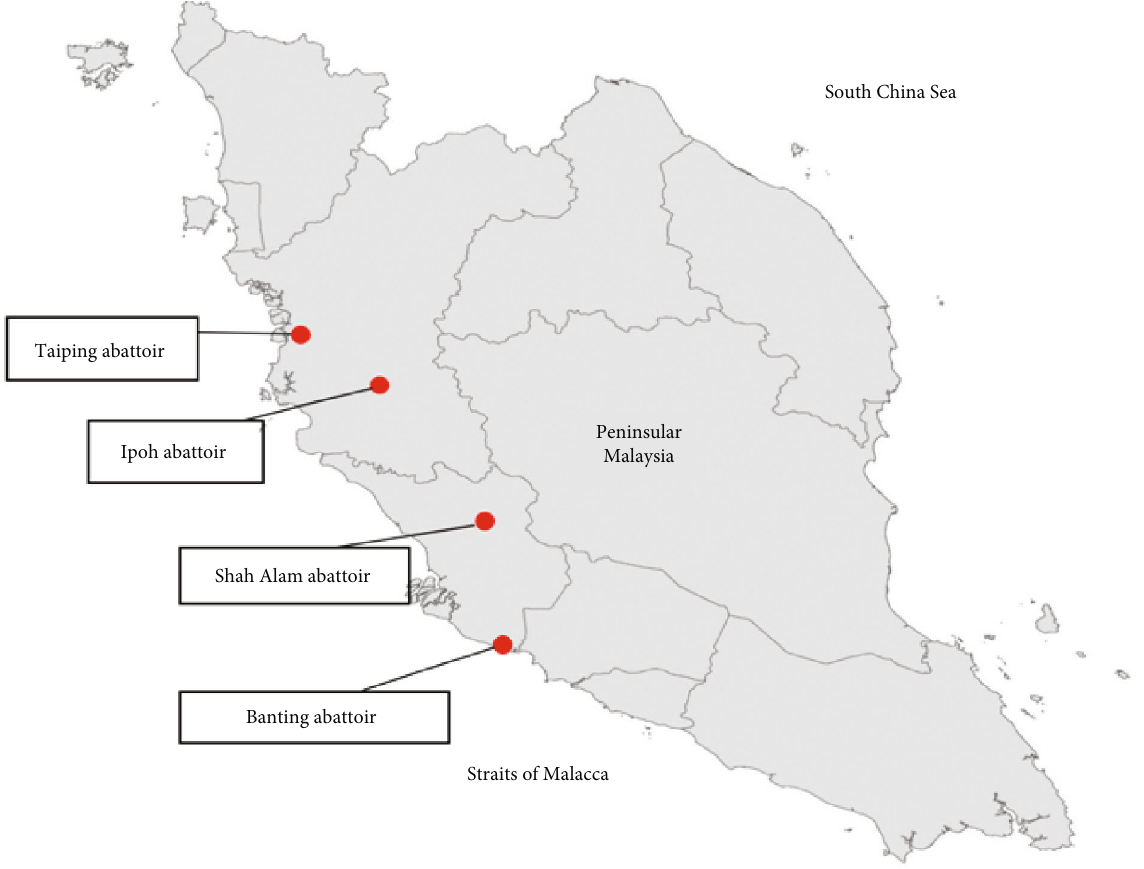
Figure 1: The location of abattoirs where all the condemn liver